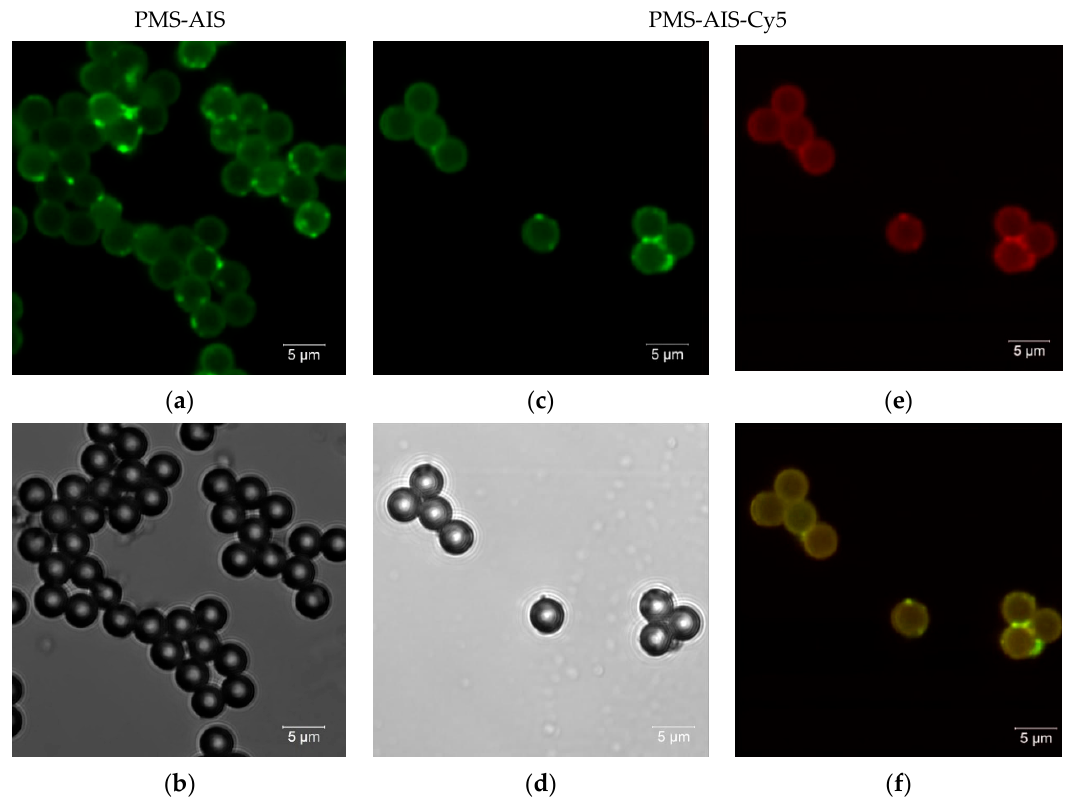
Figure 2. Confocal image of polystyrene microspheres with AIS QDs (PMS-AIS) and PMS-AIS-Cy5. PL ( a ) and transmission electron microscopy (TEM) ( b ) images of PMS-AIS; PL excitation at 405 nm, detection at 470–600 nm region. ( c , e ) correspond to the PL images of PMS-AIS-Cy5 excited by 405 nm radiation with PL detection at 470–600 nm and 650–750 nm, respectively and their superposition ( f ). ( d ) TEM images of PMS-AIS-Cy5.